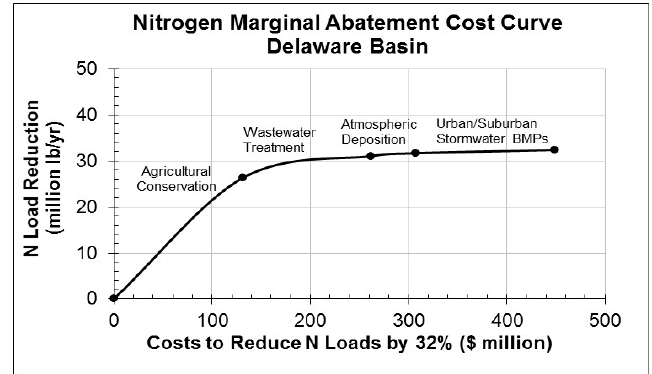
Figure 14. Nitrogen marginal abatement cost curves in the Delaware Basin.